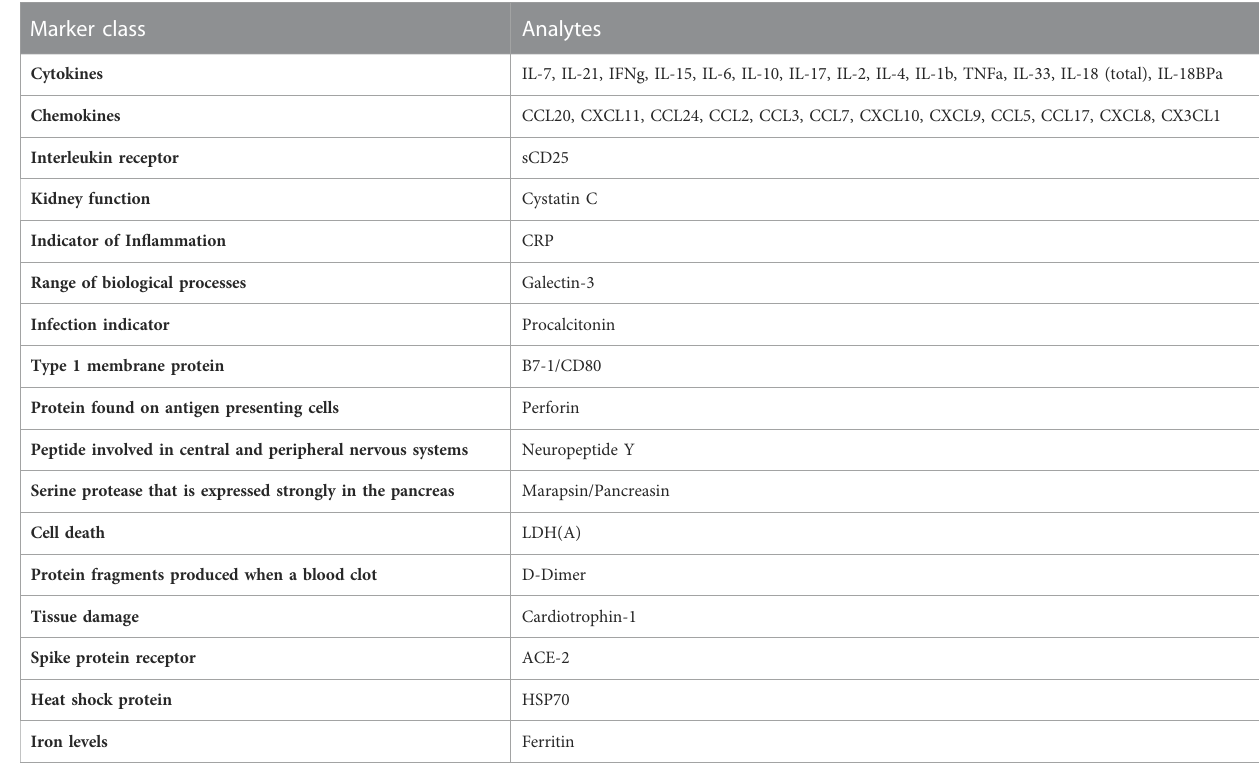
TABLE 1 Regions of interest used on fi rst generation